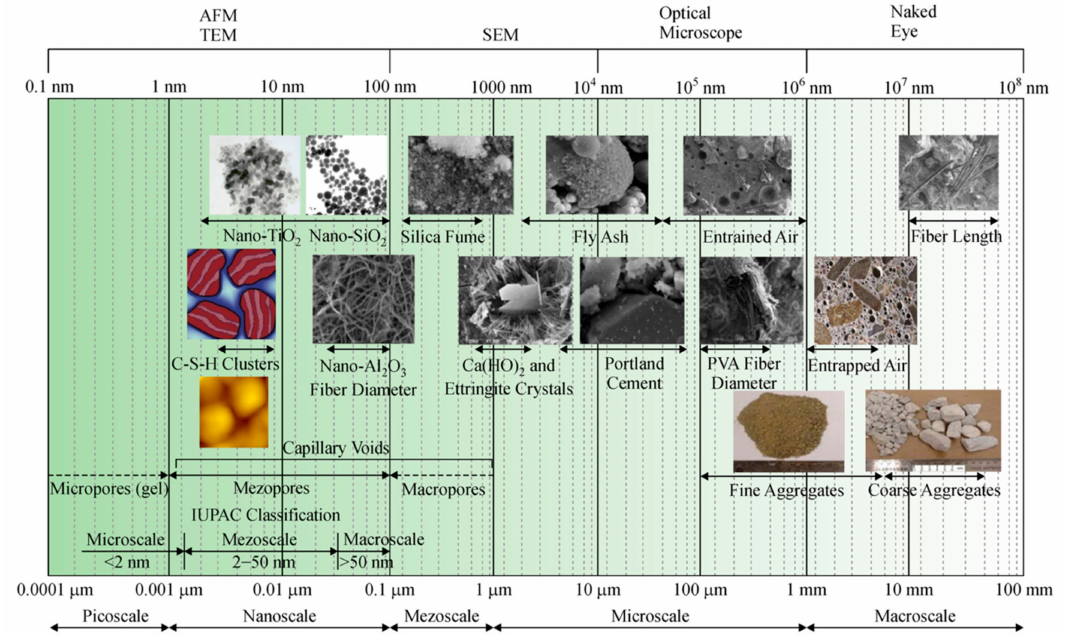
Figure 1. Scale range of several materials used in the concrete fabrication. Reprinted with permission from [77]. Copyright © 2017, Higher Education Press and Springer-Verlag, Berlin /